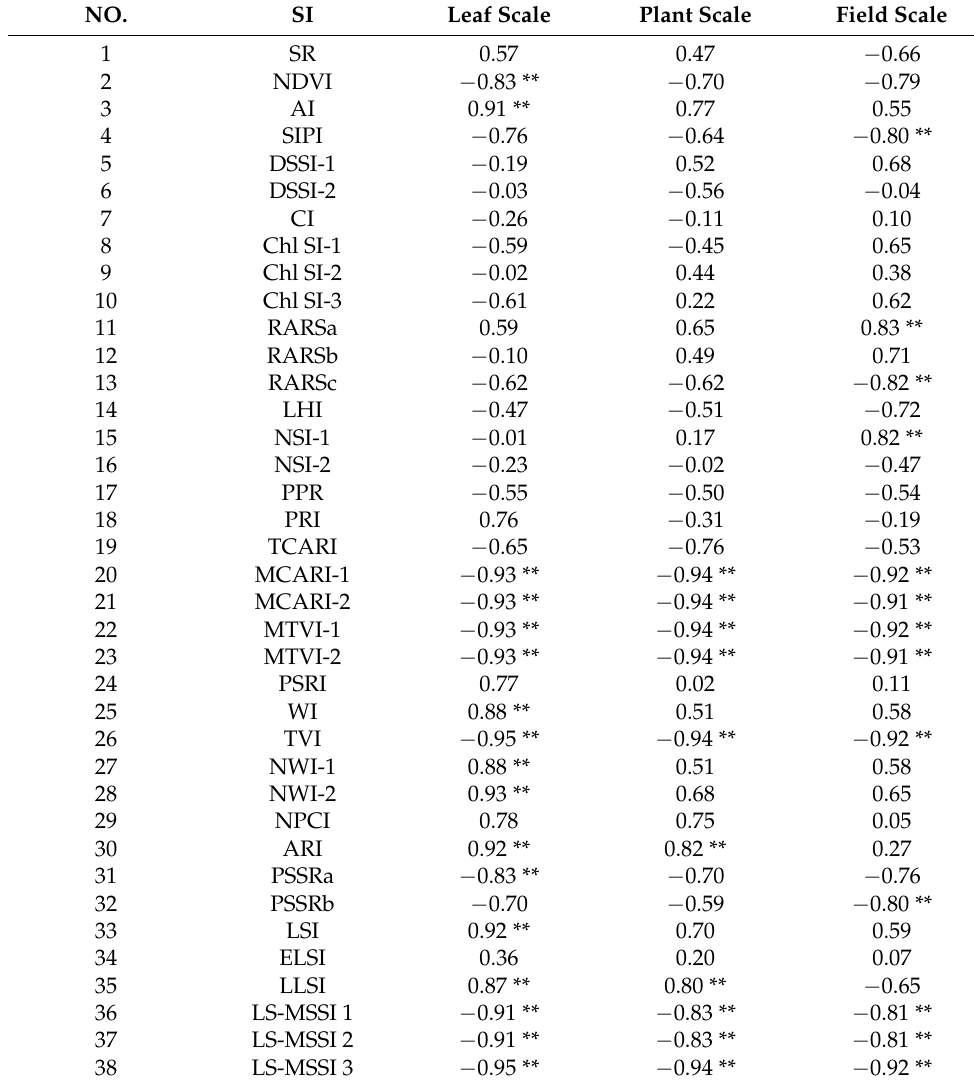
Table 7. The correlation coefficient of 38 SIs with disease severity levels.